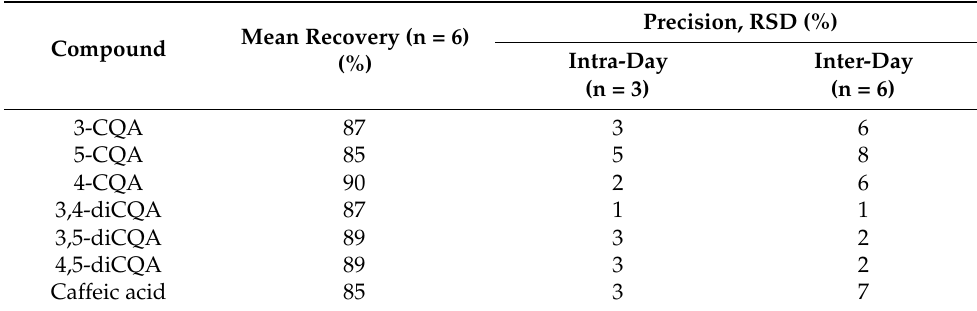
Table 2. Precision and recovery obtained in a spiked sample (5 mg g − 1 of each compound) with the capLC method.